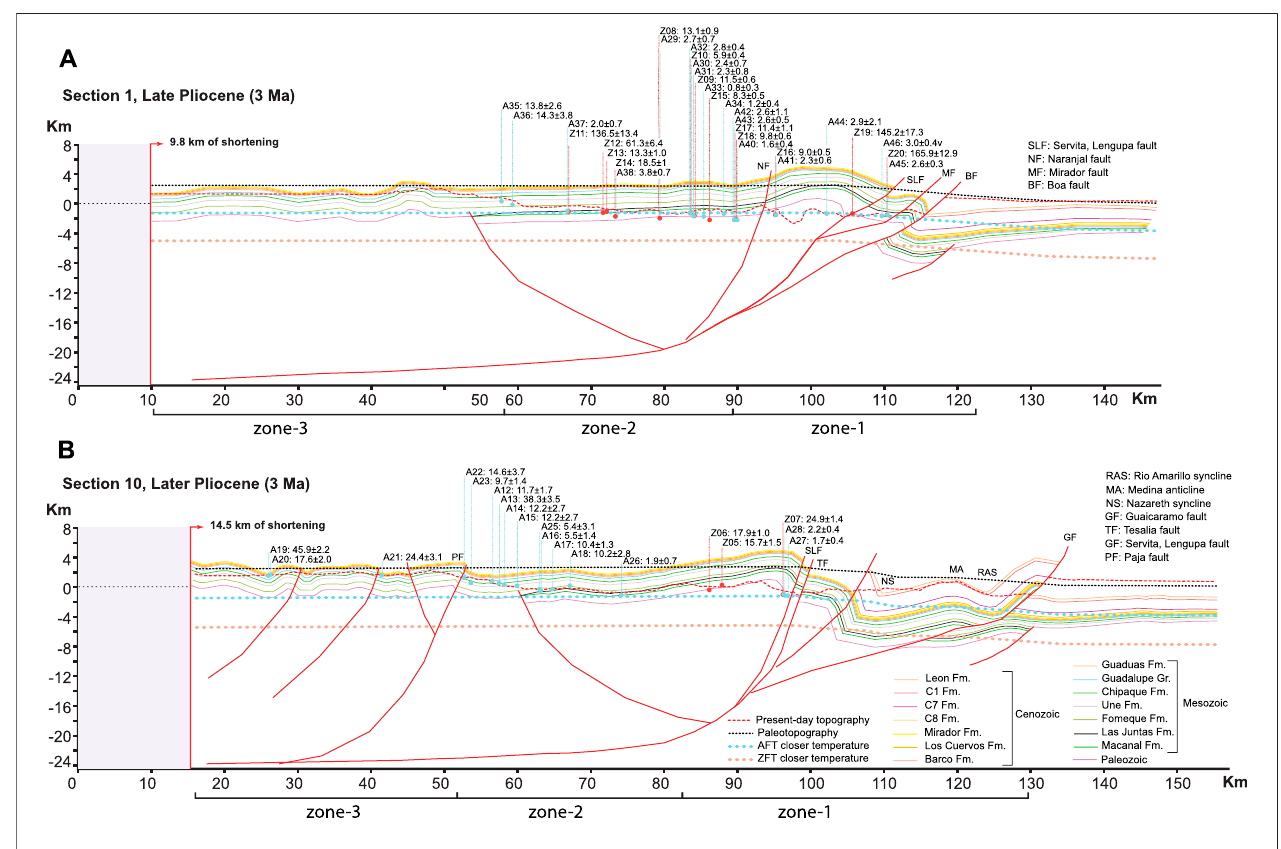
FIGURE 15 | Restoration to ∼ 3 Ma, (A) of Section 1, (B) of Section 10.